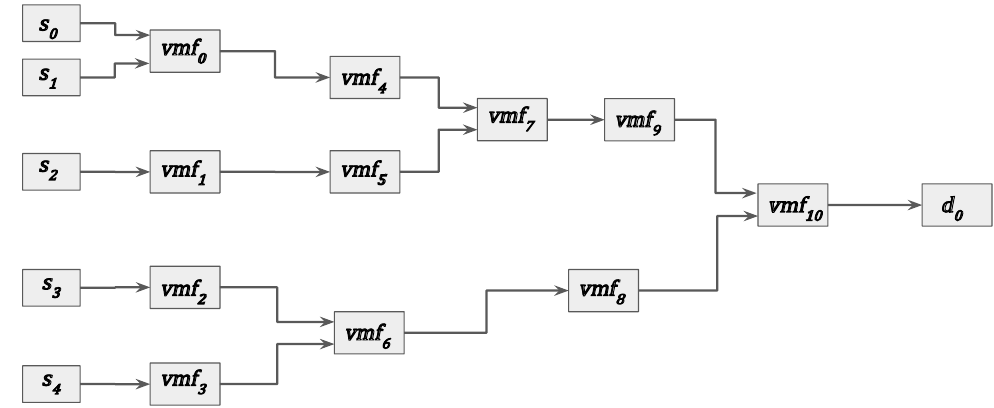
Figure 5. Illustration of the VMF-FG used for the